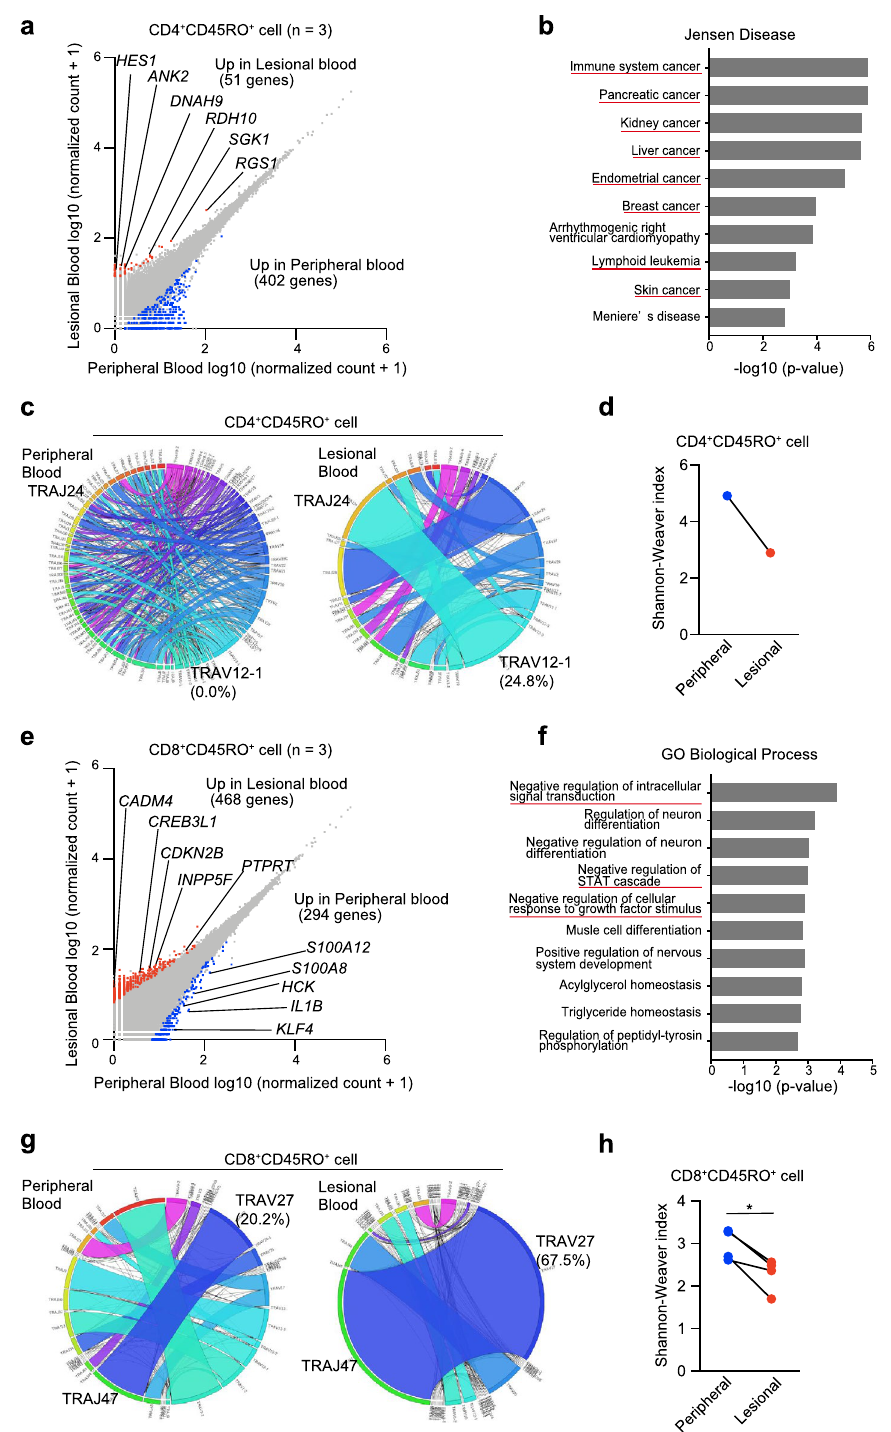
Figure 3. TCR repertoire of lesional blood is skewed, and expression of genes differs between lesional and peripheral blood. ( a ) Gene expression analysis through RNA-seq in CD4 + CD45RO + T cells of peripheral and lesional blood from 3 patients (Cases 12, 16, and 17). Scatter plots show the expression values of every annotated gene. Blue and red dots indicate significant upregulation of CD4 + CD45RO + T cells in peripheral and lesional blood, respectively. ( b ) Ten top-ranked terms from the Jensen Diseases library of Enrichr for genes upregulated in CD4 + CD45RO + T cells of lesional blood. ( c ) Circos plots of frequencies of Vα and Jα gene usage and combinations of productive sequences in CD4 + CD45RO + T cells of peripheral and lesional blood. The band widths represents the frequency of each VJ pair. ( d ) Diversity of the TCR repertoire in CD4 + CD45RO + T cells of peripheral and lesional blood was evaluated using the Shannon–Weaver Index. ( e ) RNA-seq in CD8 + CD45RO + T cells of peripheral and lesional blood from 3 patients (Cases 4, 18, and 19). ( f ) Ten top-ranked gene ontology terms of biologic processes for genes upregulated in CD8 + CD45RO + T cells of lesional blood. ( g ) Circos plots of CD8 + CD45RO + T cells of peripheral and lesional blood. ( h ) Shannon–Weaver Index of CD8 + CD45RO + T cells of peripheral and lesional